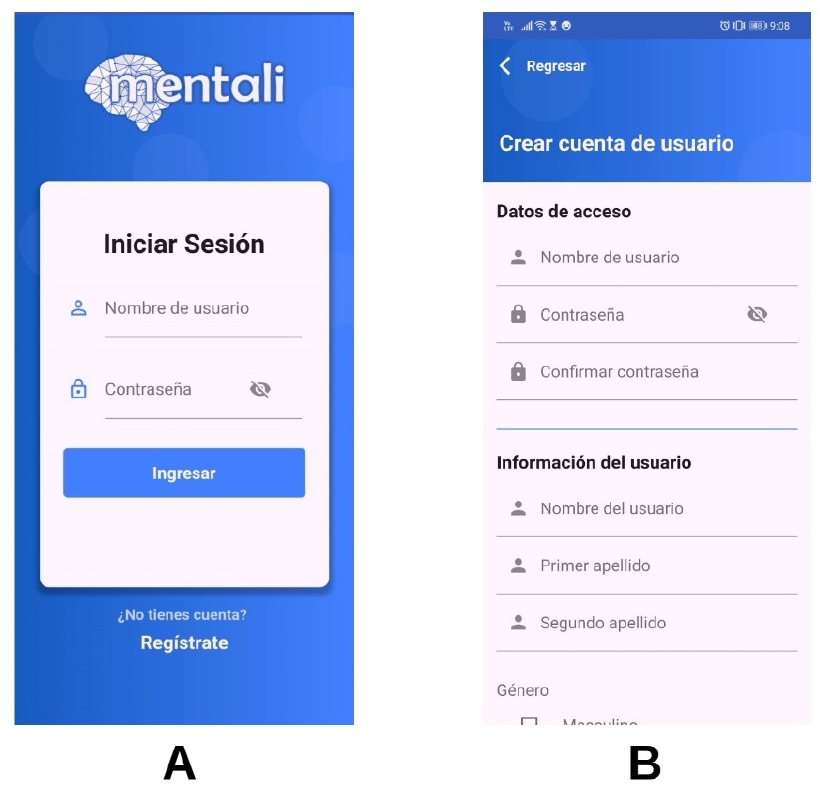
Figure 8. Login ( A ) and new account ( B )